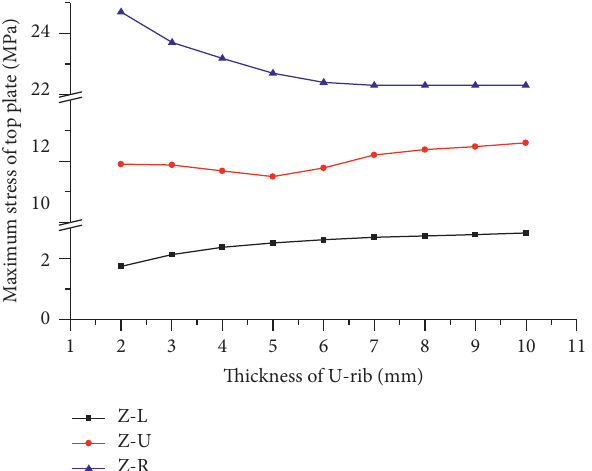
Figure 19: Influence of the change of U-rib thickness on the maximum stress in Z direction of the top plate. Table 4: Influence of changing diaphragm spacing on the maximum stress of top plate. Space of crossbeam